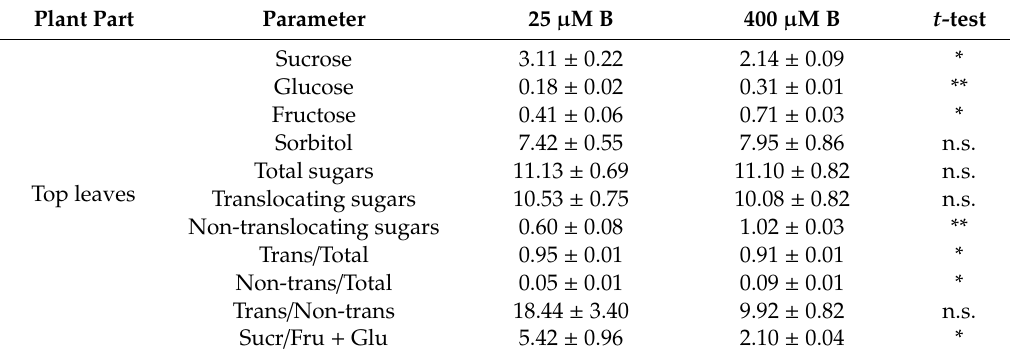
Table 5. E ff ects of B concentration in the nutrient solution (25 or 400 µ M) on carbohydrates (% DW), measured in top leaves of apple plants. Concentrations of Sucrose (Suc), Glucose (Glu), Fructose (Fru), Mannitol (Man), Sorbitol (Sorb), Total sugars (Suc + Glu + Fru + Man + Sorb), Translocating sugars (Trans; Suc + Man + Sorb), Non-translocating sugars (Non-trans; Fru + Glu), the ratios Trans / Non-trans, Trans / Tot, Non-trans / Tot and Starch in control (25 µ M B) and high B-treated (400 µ M B) apple plants. Plant Part Parameter 25 µ M B 400 µ M B t- test Sucrose 3.11 ±